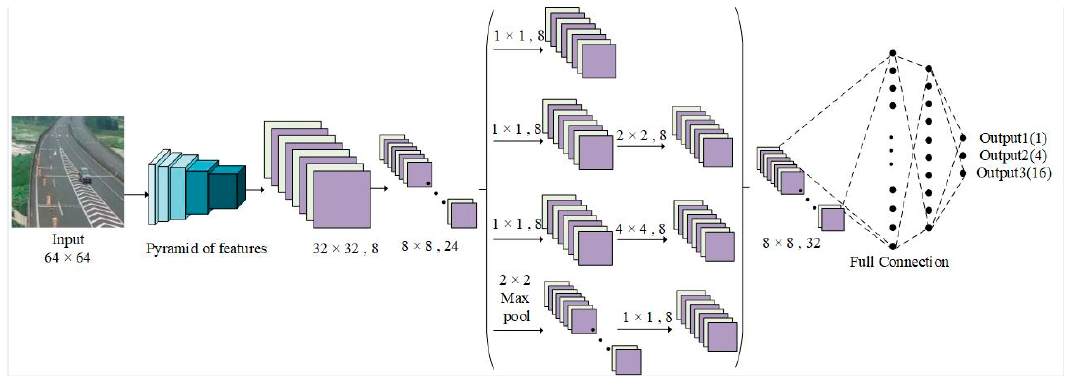
Figure 4. CNN-based intra prediction CU fast partition algorithm model structure diagram.